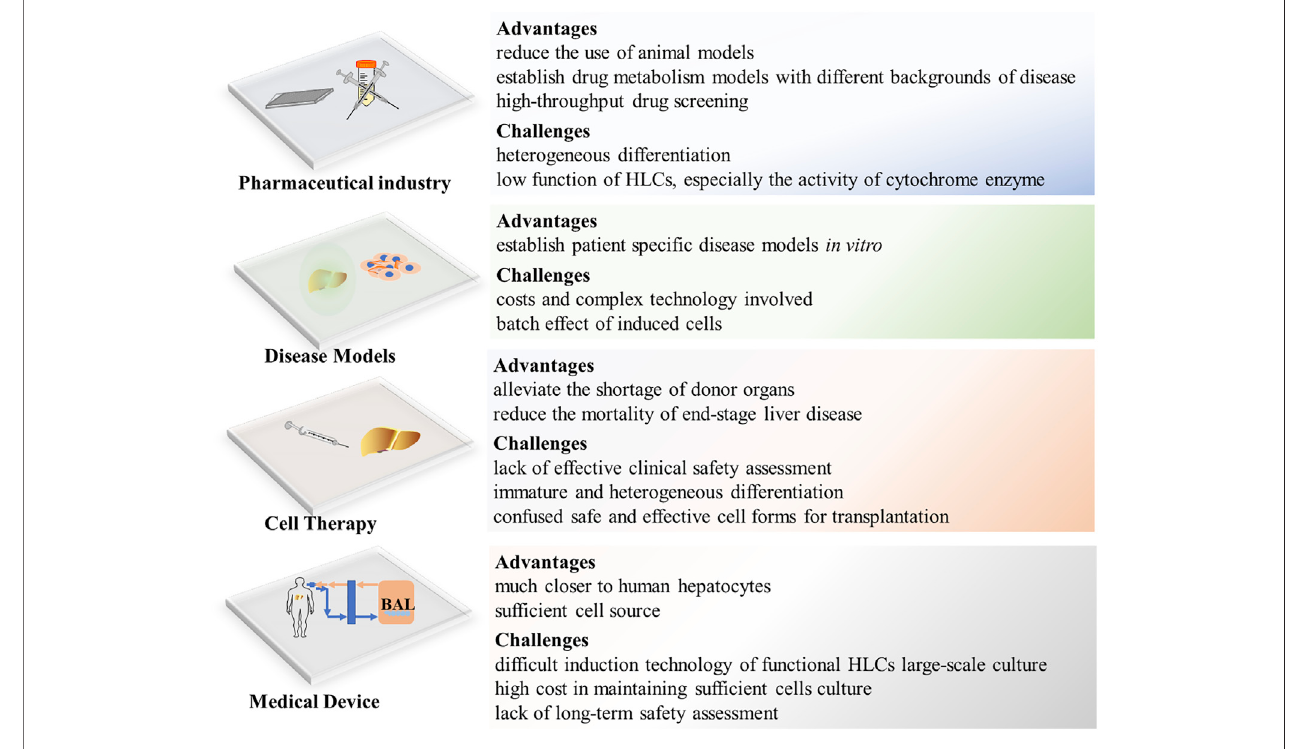
FIGURE 4 | Applicaton and Challenges of HLCs, BAL, bioarti fi cial liver.